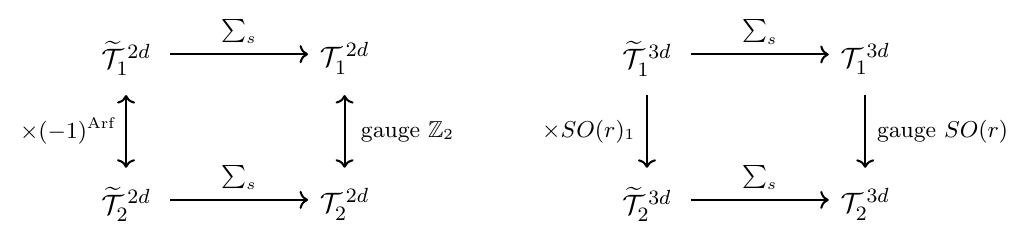
Figure 3: The relation between the two spin theories (cid:101) and the two non-spin the- T 1,2 ories in (1 + 1) d (left) and in (2 + 1) d (right). Compared to the main text, the T 1,2 superscripts “3 d " are added for clarity. In the figure on the left, ( − 1 ) Arf can be repre- sented by a (1 + 1) d spin (cid:90) gauge theory with action given by the right hand side of 2